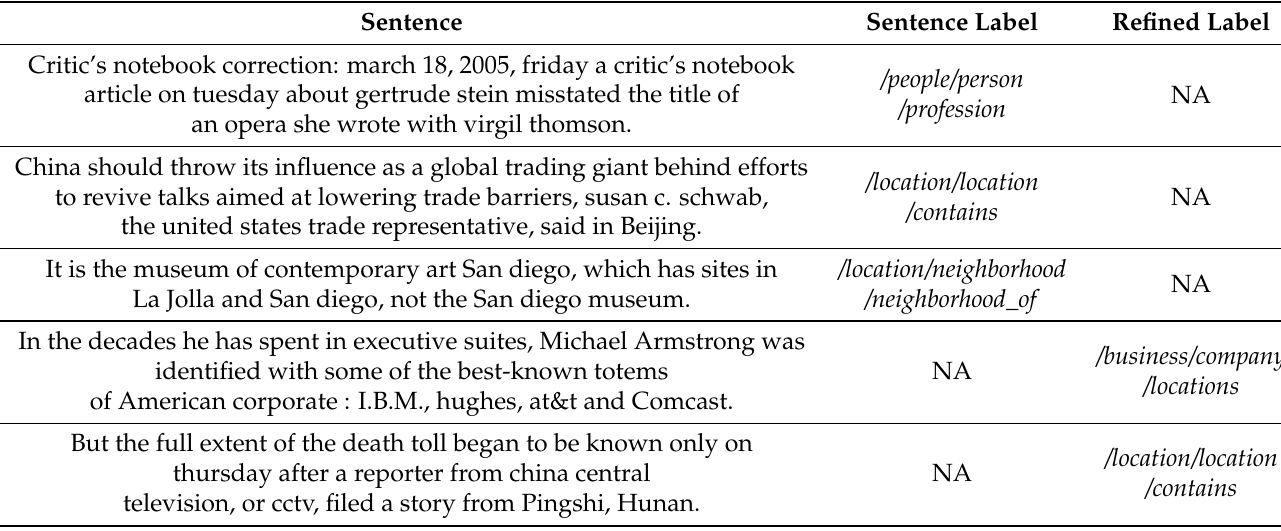
Table 4. Some examples of the model-refined NYT